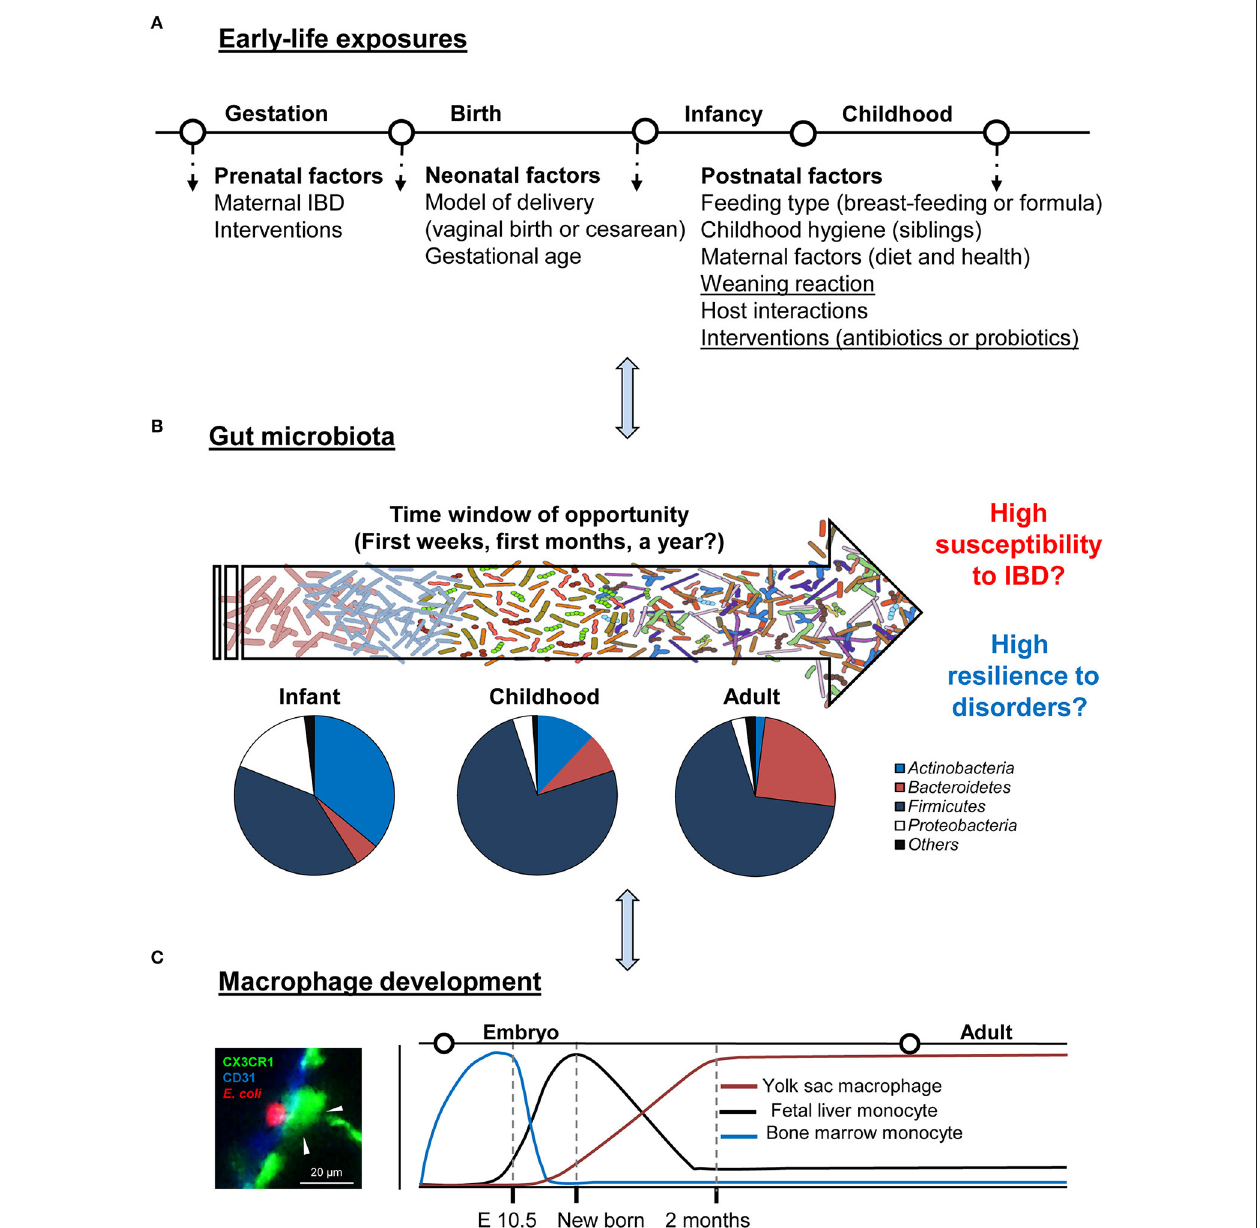
FIGURE 1 | Critical time window: gut development and regulation. (A,B) Schematic summary of early-life environmental factors that impact the gut microbiota establishment of an individual and drive its phenotype toward health or IBD. Typical phylum-level of microbiota composition in healthy individuals in different life stages and the window of opportunity for possible modulation. (C) Gut resident macrophage ontogeny in the steady-state. A representative image of colon macrophage (green), interacting with Escherichia coli (red, left panel).